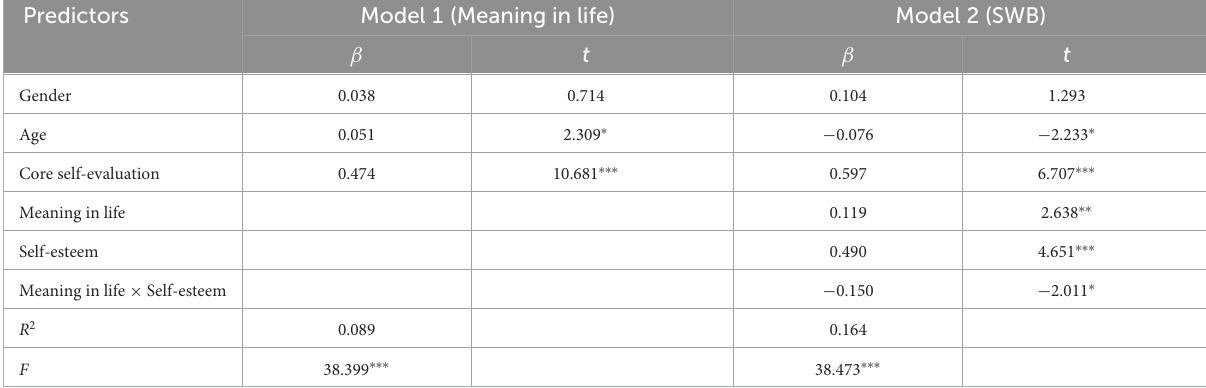
TABLE 3 Results of self-esteem moderate the mediation